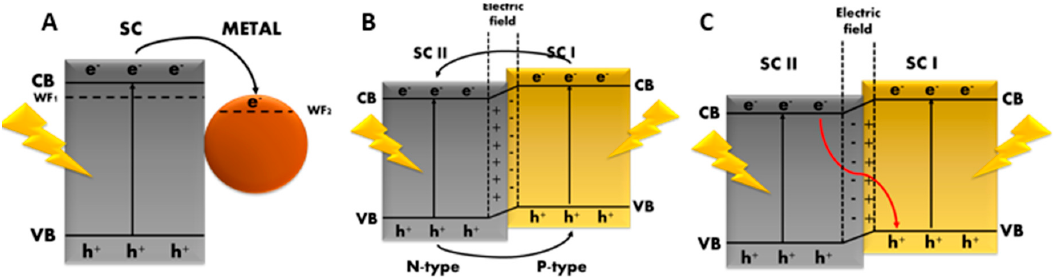
Figure 4. ( A ) Schottky junction. ( B ) P–n heterojunction. ( C ) S-type heterojunction.